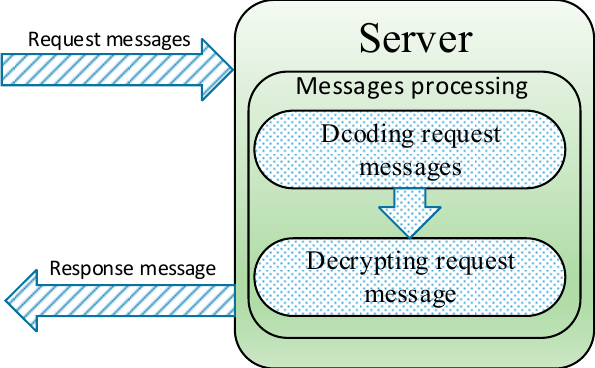
Figure 38. Generated server-side abstract model of the RSAAuth system.